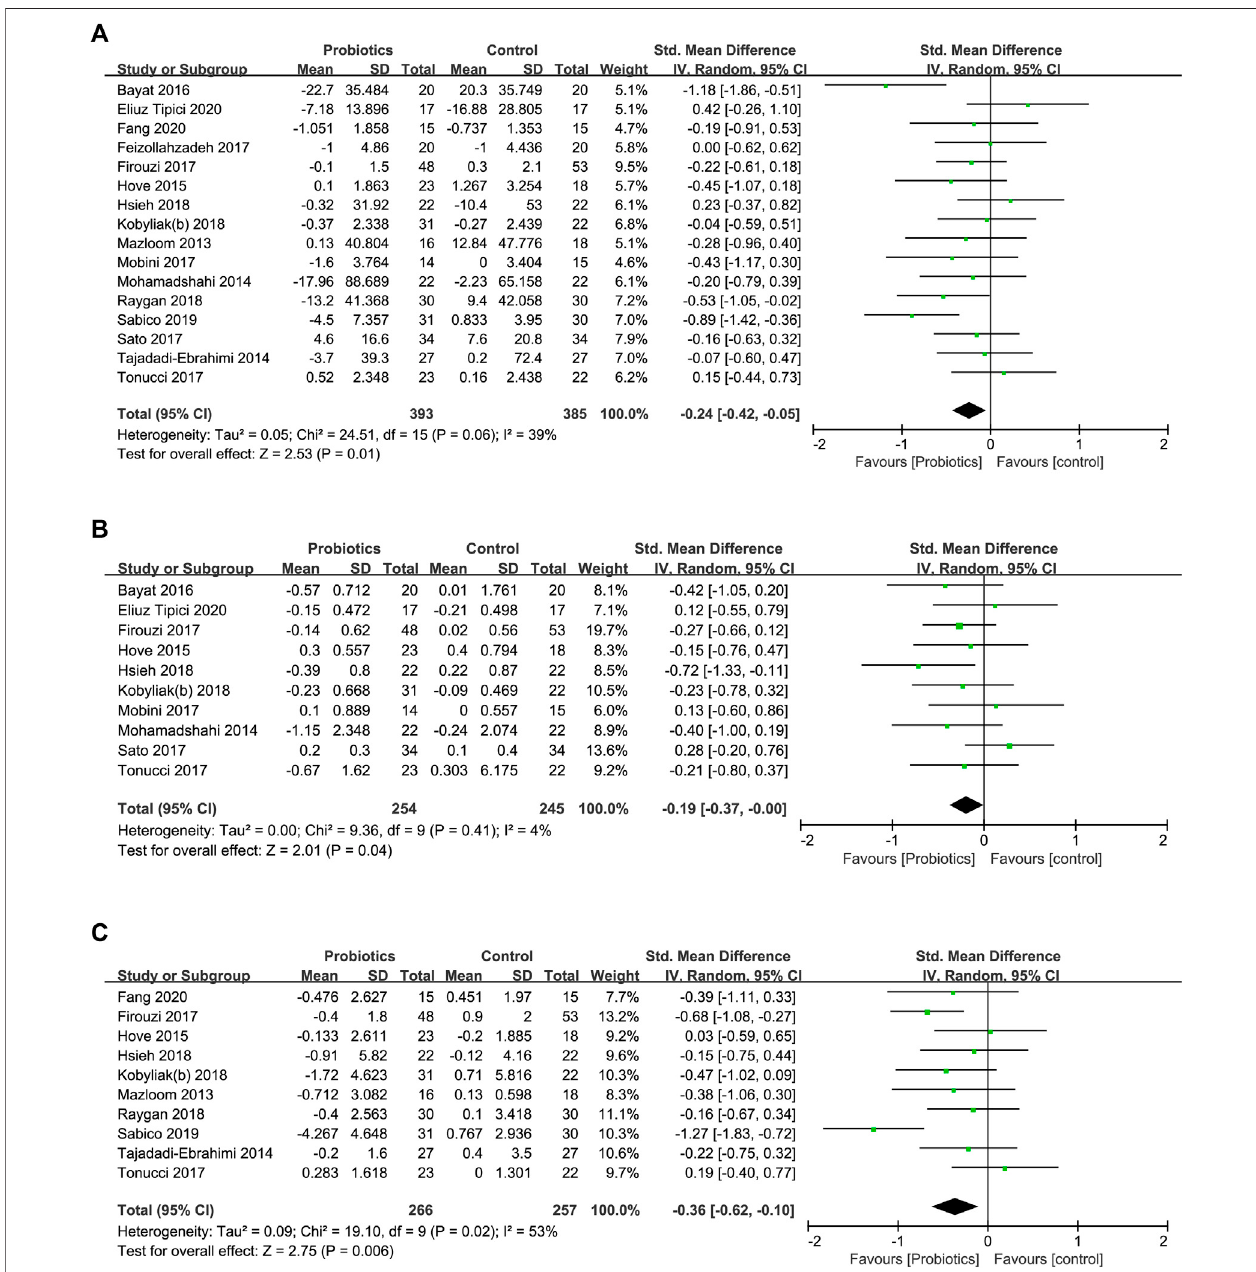
FIGURE 5 | Forest plots of the effects of probiotics on (A) FPG, (B) HbA1c, (C) HOMA-IR.